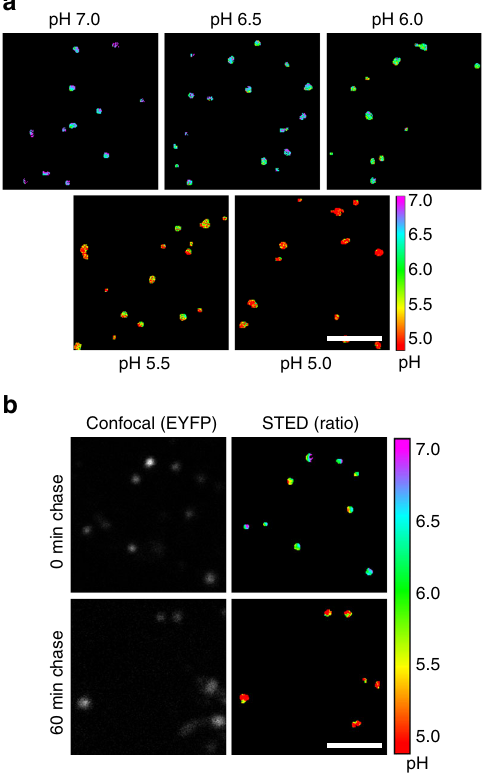
Fig. 5 Ratiometric imaging of SRpHi produces reliable measurements of endosomal pH. a Ratiometric (FP/dye) STED images of live MEF cells loaded with SRpHi1 and equilibrated to the indicated pH using a citric acid/ phosphate buffer supplemented with 140 mM KCl and 1 µ M nigericin. b Ratiometric STED imaging of pulse-chase experiments performed in MEF cells loaded with SRpHi1. Cells in the top row received a 10 min pulse of SRpHi1 prior to imaging. Cells in the bottom row received the same pulse followed by a 60 min chase in SRpHi1-free medium. Scale bars : 2 µ